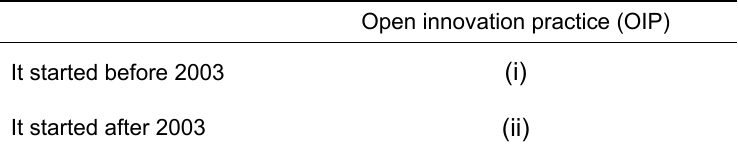
Table 4. Classification of open innovation practice (OIP)